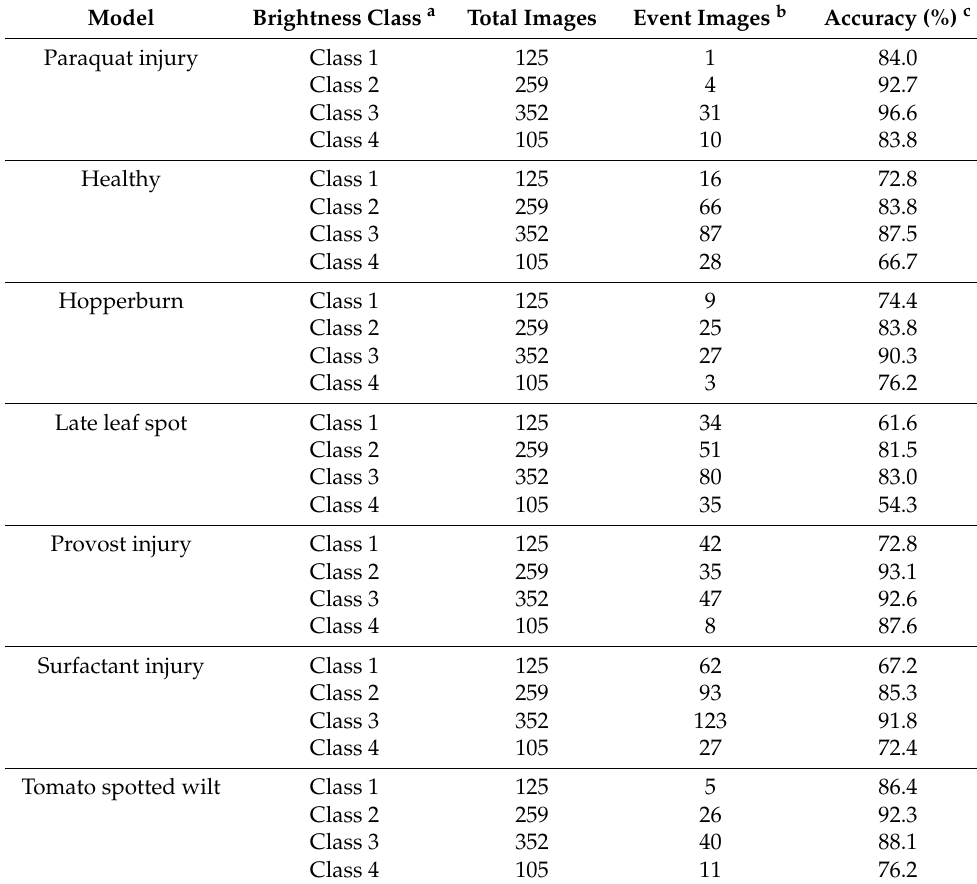
Table 4. The total number of images, the number of event images and the accuracy of each brightness class by